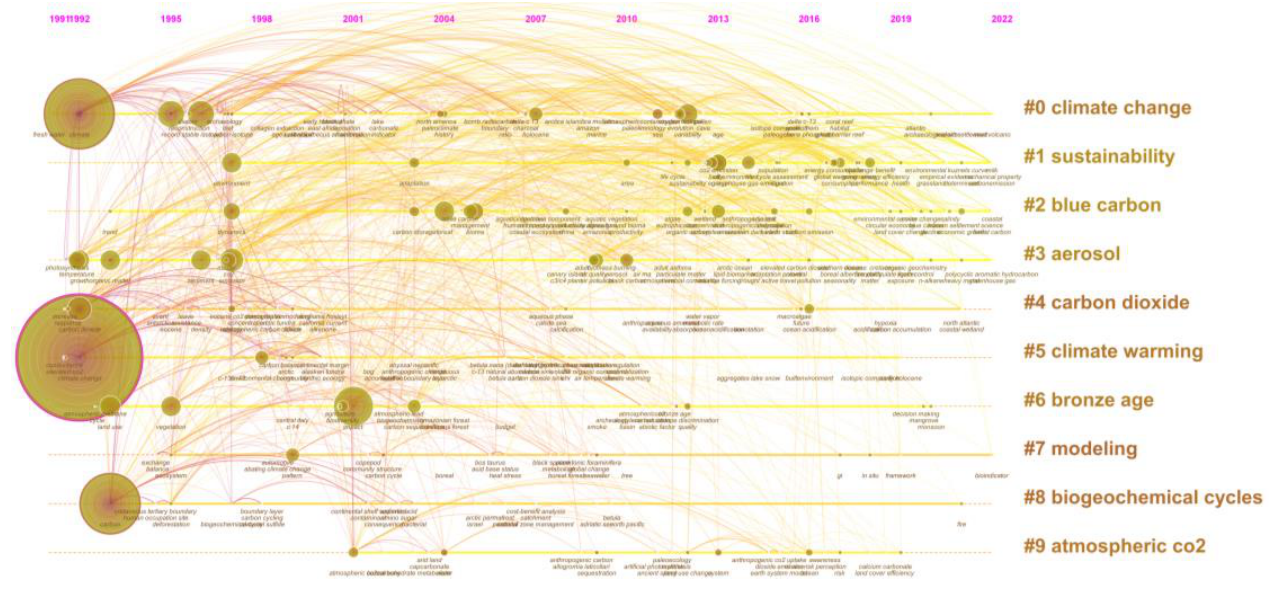
Figure 9. RCHSCC time-zoned axial mapping (top 10 categories).